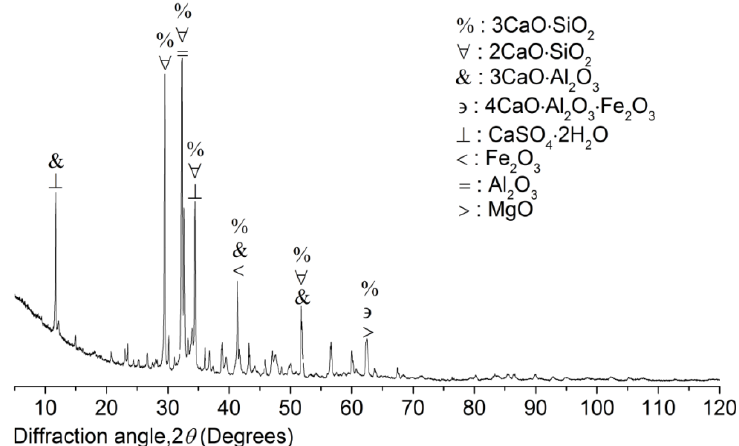
Figure 7. XRD patterns of composite Portland cement P.C 42.5